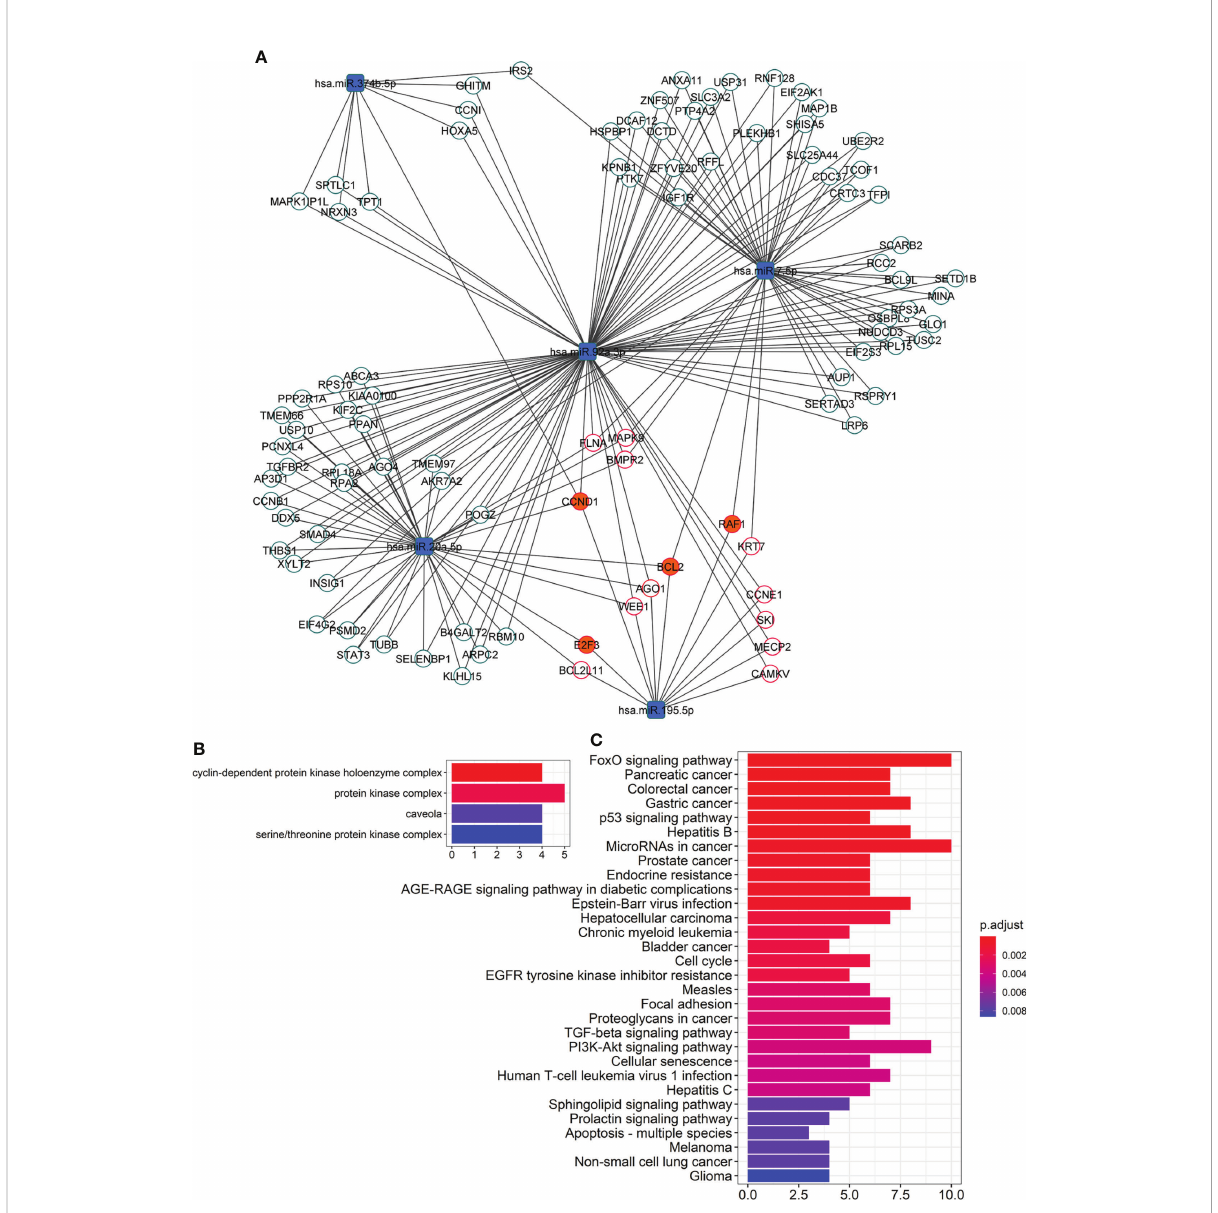
FIGURE 3 Network of overtargeted miRNA-mRNA interactions. (A) This particular type of network, only includes transcripts validated to interact with the differentially expressed DE miRNAs that were found to be targeted by more DE miRNAs than expected by chance ( “ miRNA-overtargeted ” ). (B) Cellular compartments enriched among the annotations of the miRNA-overtargeted genes. (C) KEGG pathways enriched among the annotations of the miRNA-overtargeted